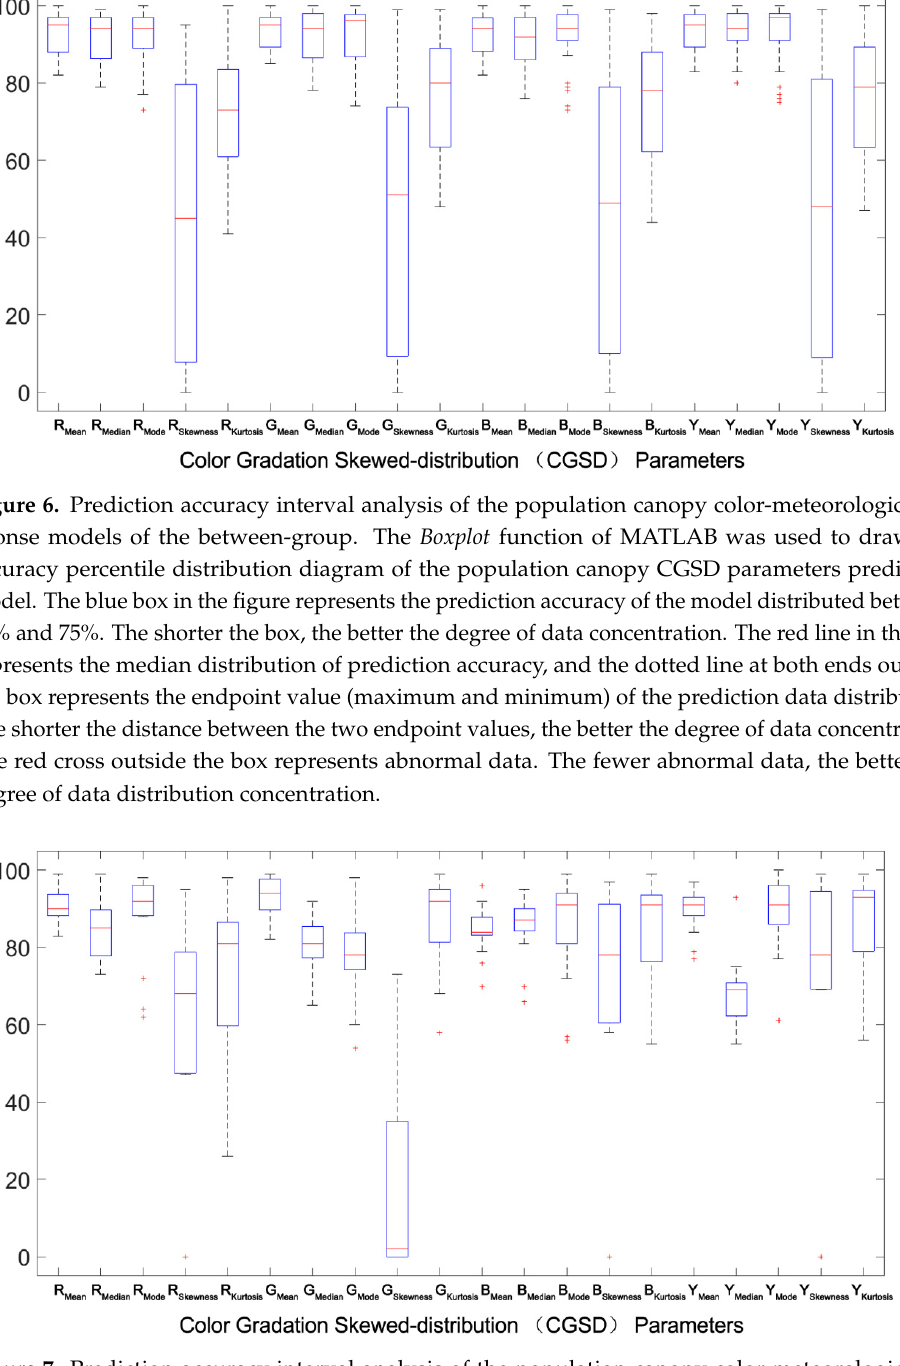
Figure 7. Prediction accuracy interval analysis of the population canopy color-meteorological re- sponse models of the outside-group. The Boxplot function of MATLAB was used to draw the accu- racy percentile distribution diagram of the population canopy CGSD parameters prediction model. The blue box in the figure represents the prediction accuracy of the model distributed between 25% and 75%. The shorter the box, the better the degree of data concentration. The red line in the box represents the median distribution of prediction accuracy, and the dotted line at both ends outside the box represents the endpoint value (maximum and minimum) of the prediction data distribution. The shorter the distance between the two endpoint values, the better the degree of data concentra- tion. The red cross outside the box represents abnormal data. The fewer abnormal data, the better the degree of data distribution concentration. 3.4. Optimization of Canopy Color Skewness-Meteorological Models Although the skewness of the red and green channels, and the gray-level image per- formed well, the between-group and outside-group prediction accuracy were generally lower than other CGSD parameters. The skewness was non-linear to microclimate factors [33]. Therefore, we fitted the polynomial Z1-Z4 that incorporates spatial bidirectional pat- terns for the RGB channels, and the gray-level image, by taking two accumulation factors, i.e., the accumulated temperature ( x 1 ) and the accumulated photosynthetically active ra- diation ( x 5 ) as the independent variables, which had the highest absolute value of the cor- relation coefficient. Z1 = 0.3629 + 0.6382 × 10 − 3 x 1 + 2.626 × 10 − 3 x 5 + 5.312 × 10 − 6 x 1 2 − 1.072 × 10 − 5 x 1 x 5 (4) Z2 = 0.2242 + 0.5163 × 10 − 3 x 1 + 3.11 × 10 − 3 x 5 + 3.08 × 10 − 6 x 1 2 − 7.463 × 10 − 6 x 1 x 5